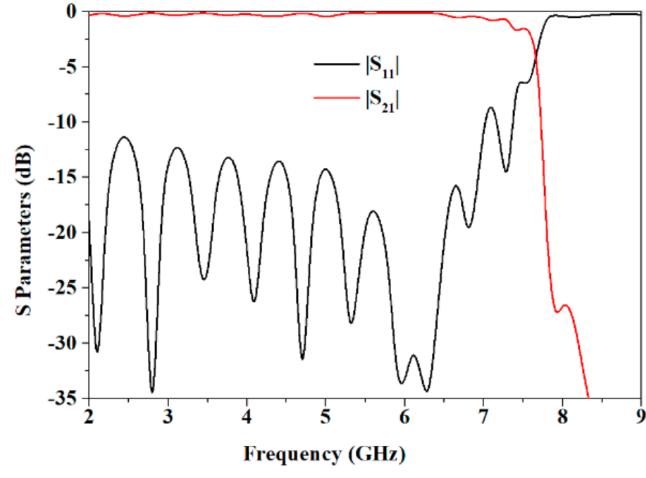
Figure 3. S parameters of the parallel SSPPs-TL with h = 4